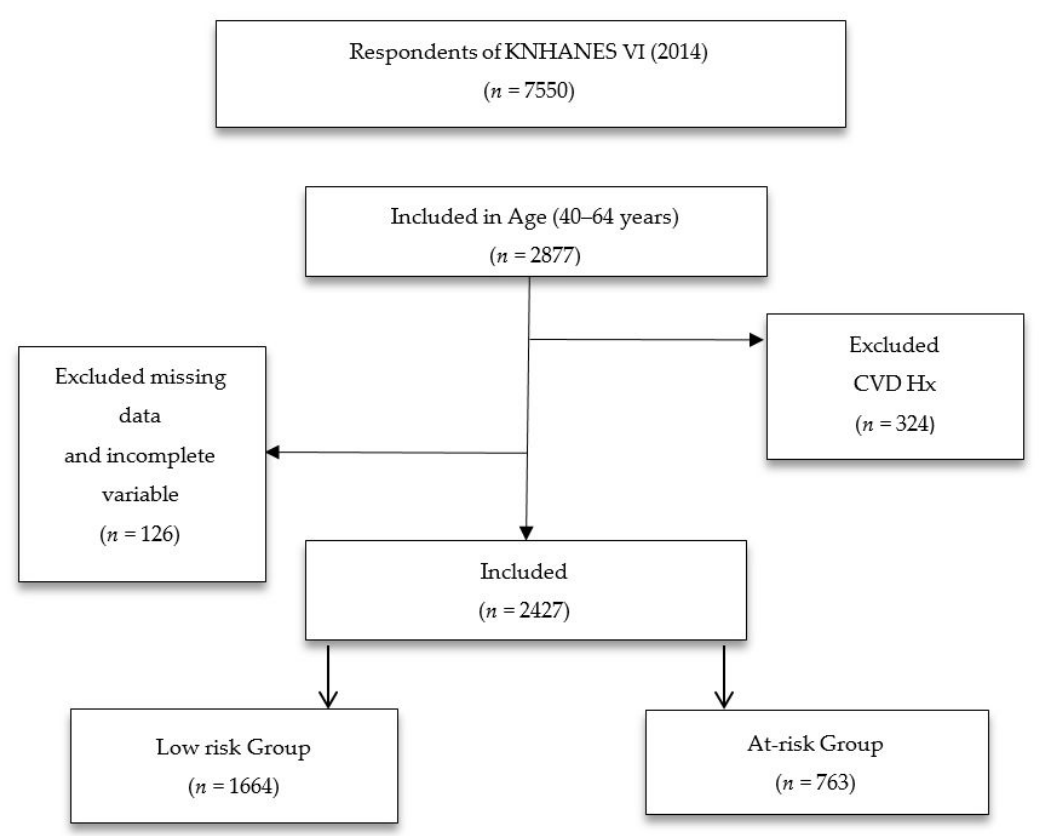
Figure 1. Flow chart of the study population. Abbreviations: CVD, cardiovascular disease; KNHANES VI, Korea National Health and Nutrition Examination Survey